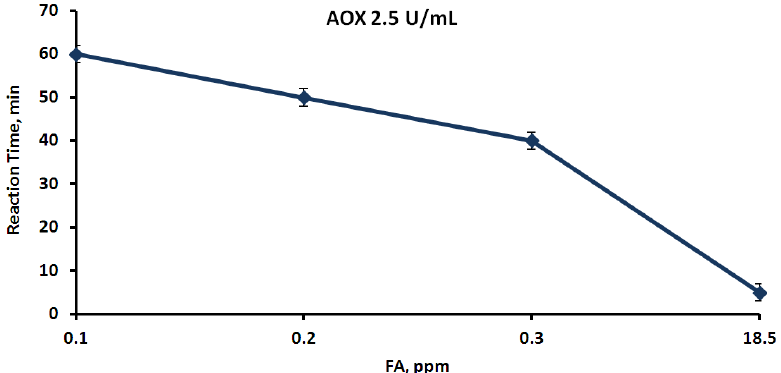
Figure 6. Time of color development in the membrane devices containing exposed to airborne FA at various concentrations and the reaction time was